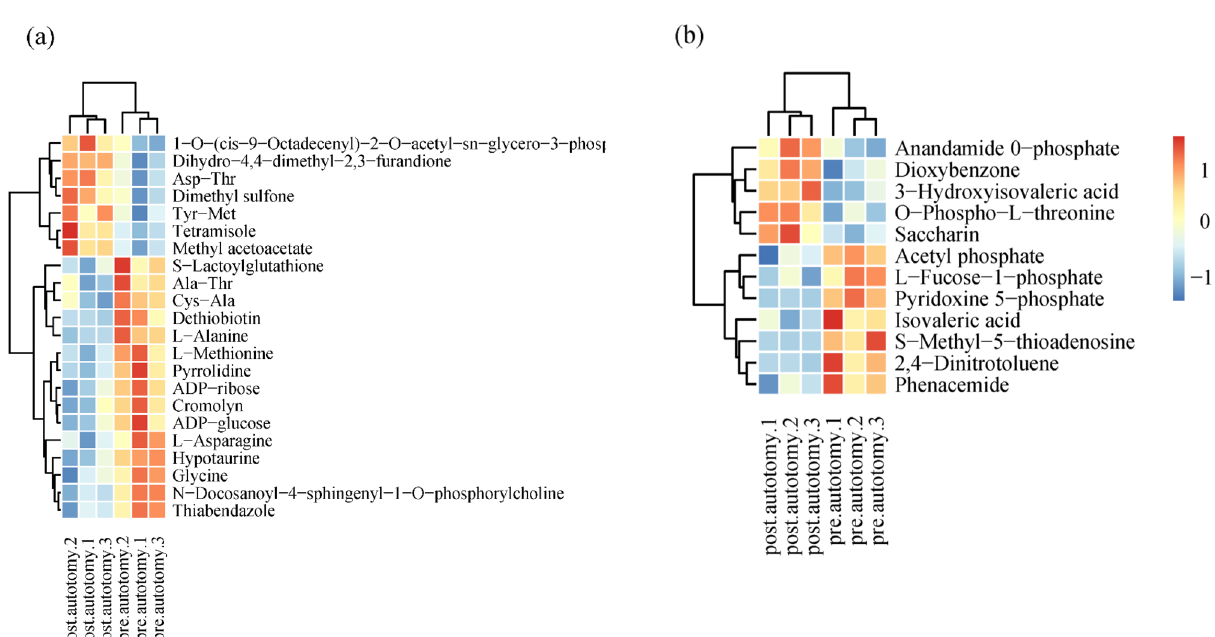
Figure 6. Hierarchical clustering analysis thermal map based on significantly differential metabolites (SDMs) from ( a ) positive ion (POS) and ( b ) negative ion (NEG) modes. The relative metabolite level is depicted according to the color scale; red and blue indicate upregulation and downregulation,